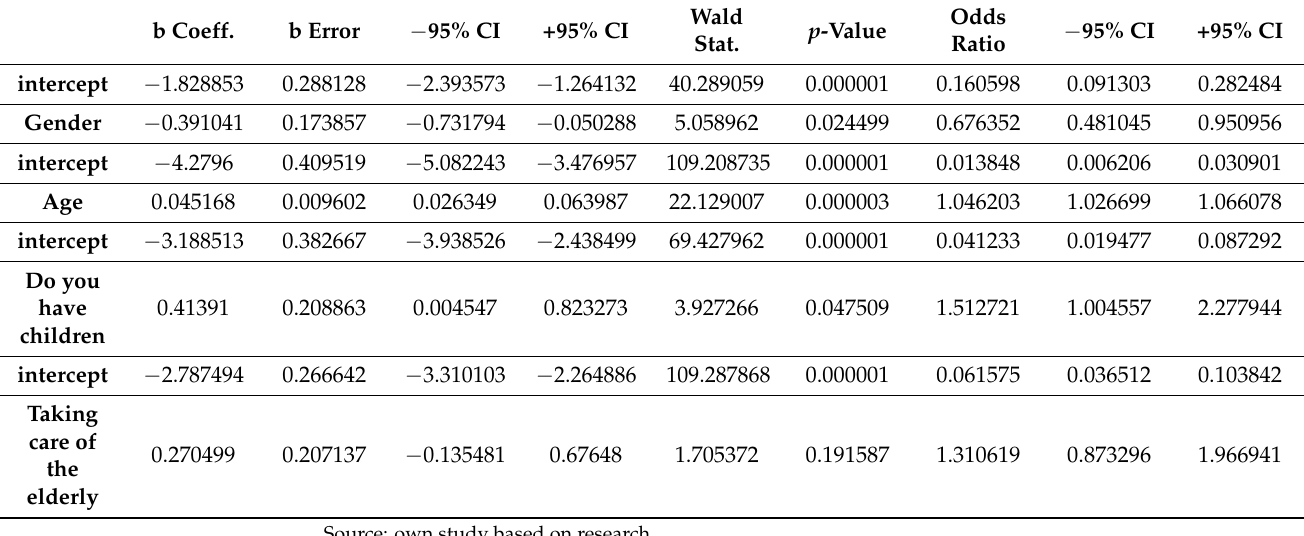
Table 6. Logistic regression model for somatic fear symptoms and demographics.